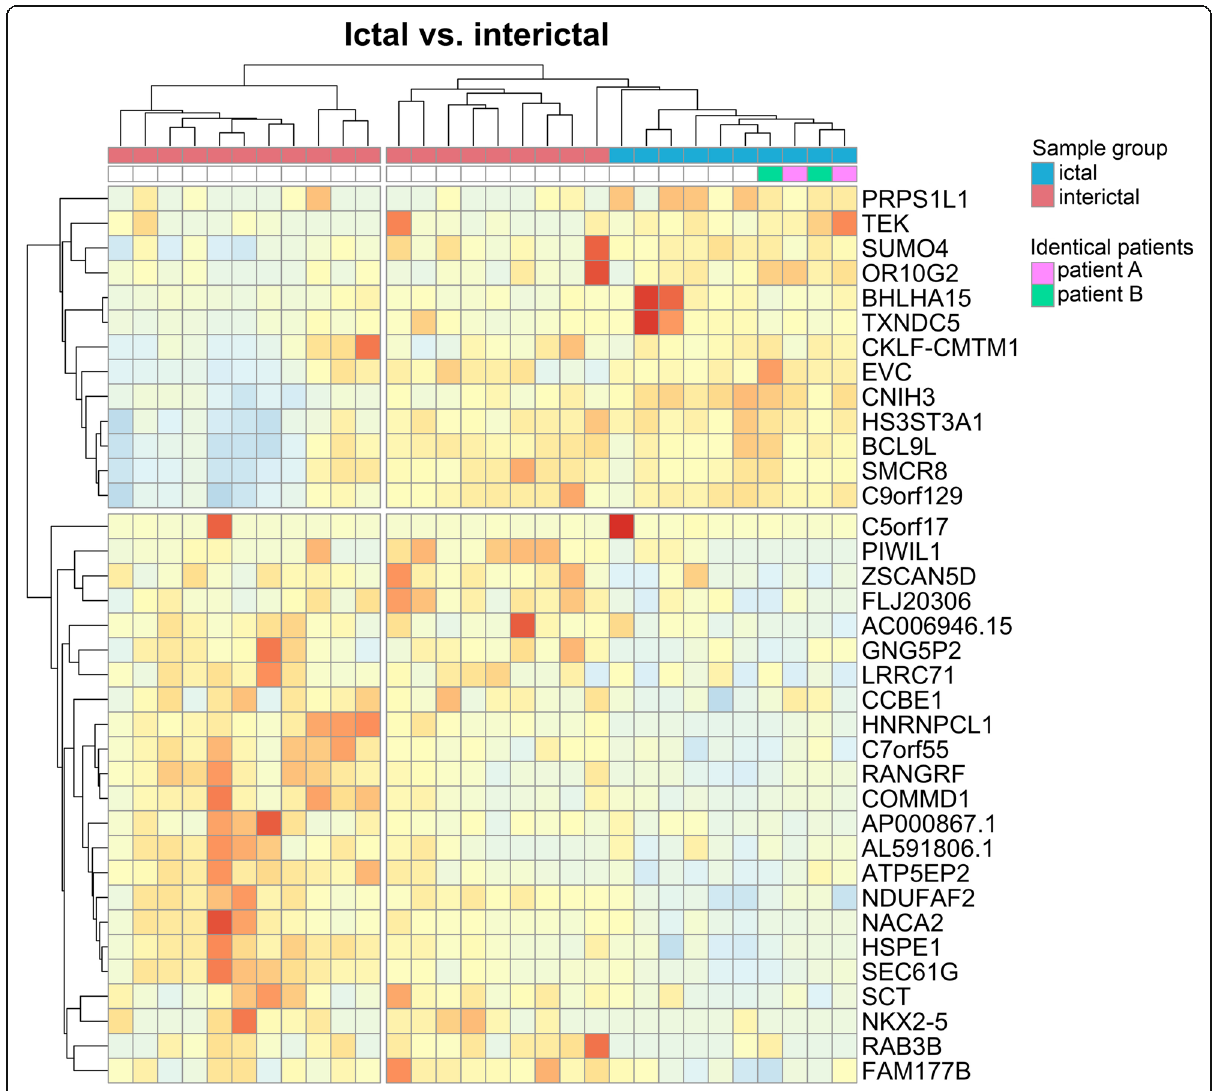
Fig. 2 Heat map representation of differentially expressed genes in the ictal vs. interictal comparison. Columns represent samples, rows represent genes. Pearson correlation was respectively calculated between samples and genes, visualized by dendrograms. Ictal samples from identical patients ( “ A ” , “ B ” ) are marked with respective colors in the